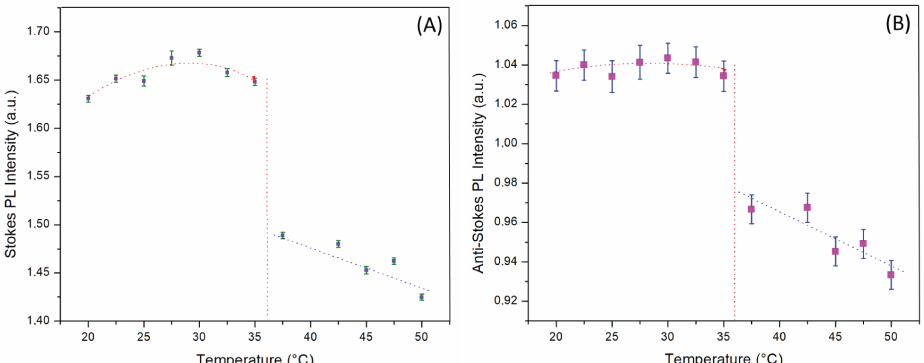
Figure 7. Variation of Stokes ( A ) and anti-Stokes ( B ) fluorescence intensities of RhB in fluorocarbon oil under 0.5 mW power illumination. We observe two temperature intervals: (i) below 36 ◦ C, where the fluorescence intensity is more or less constant, (ii) and above 36 ◦ C, where the fluorescence intensity decreases linearly versus temperature with a temperature sensitivity of about − 0.3%/ ◦